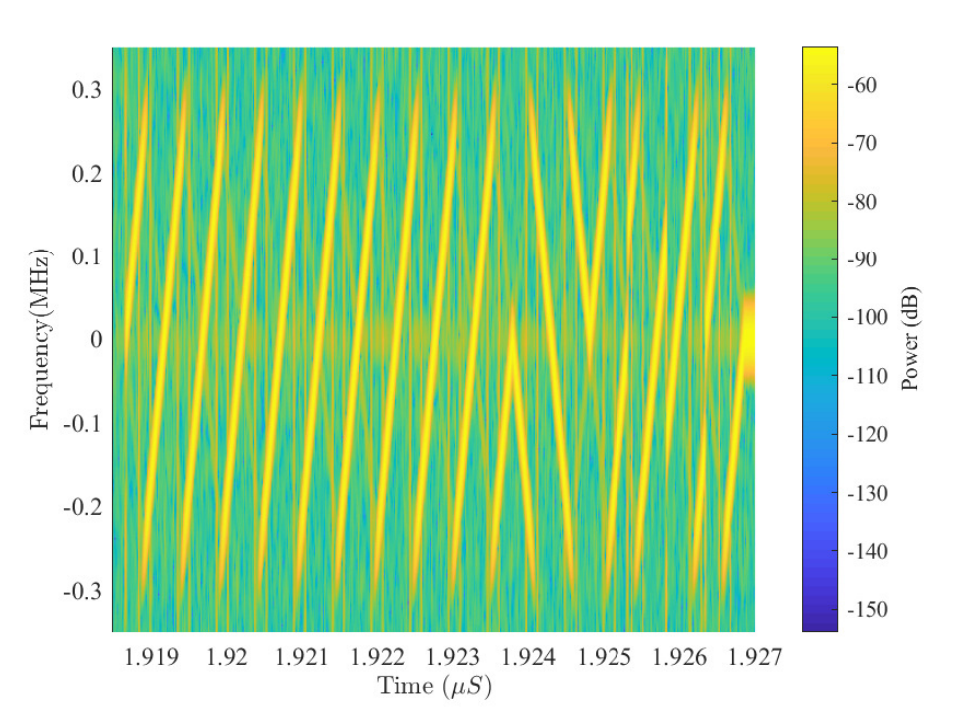
Figure 8. Reception